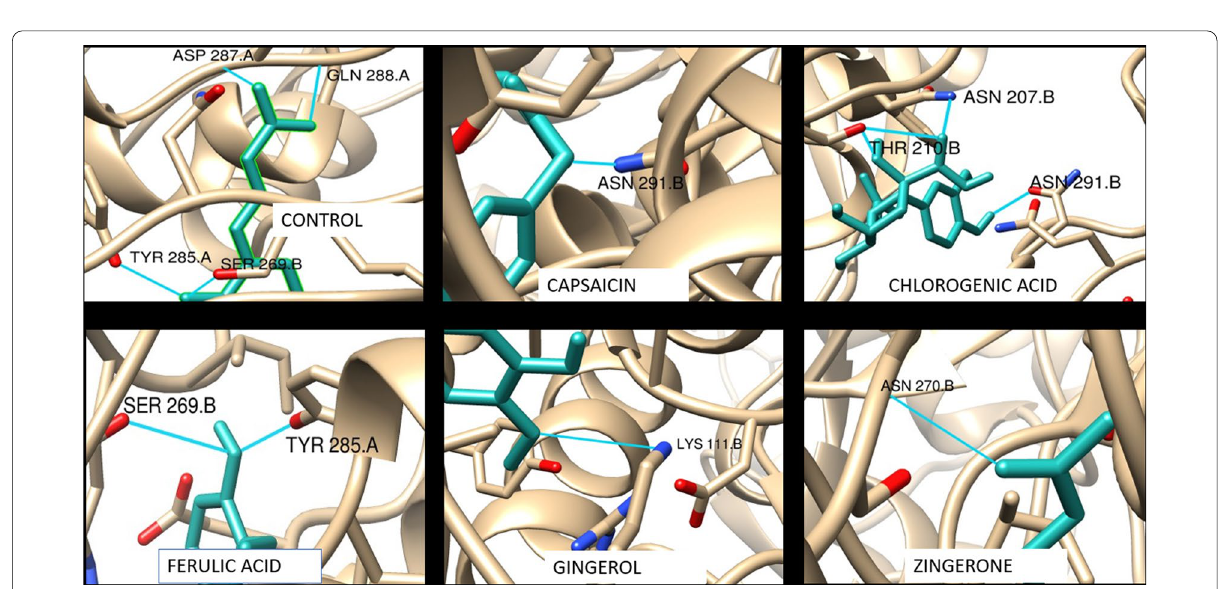
Fig. 3 Docked pictures of curcumin analogues and Triapine (control) against RNRM1 receptor. (Ligand represents the blue sticks, hydrogen bond interaction is represented in blue line, and receptor is represented in solid white ribbon